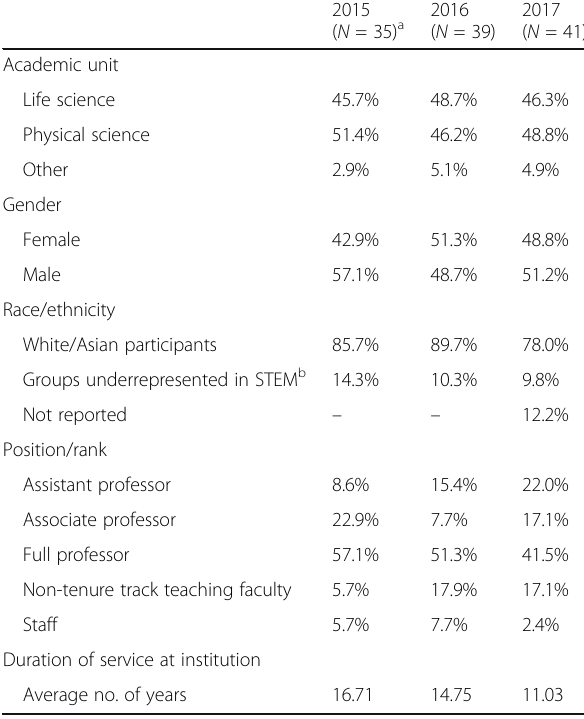
Table 1 Demographic characteristics of workshop